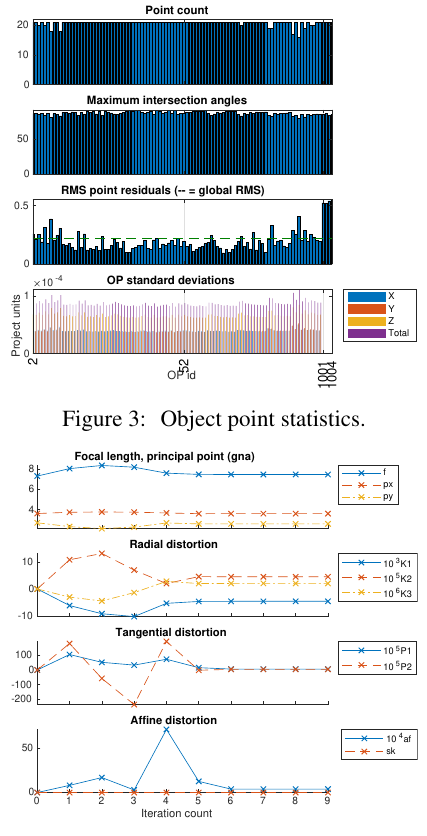
Figure 4: Parameter evolution during the bundle iterations.